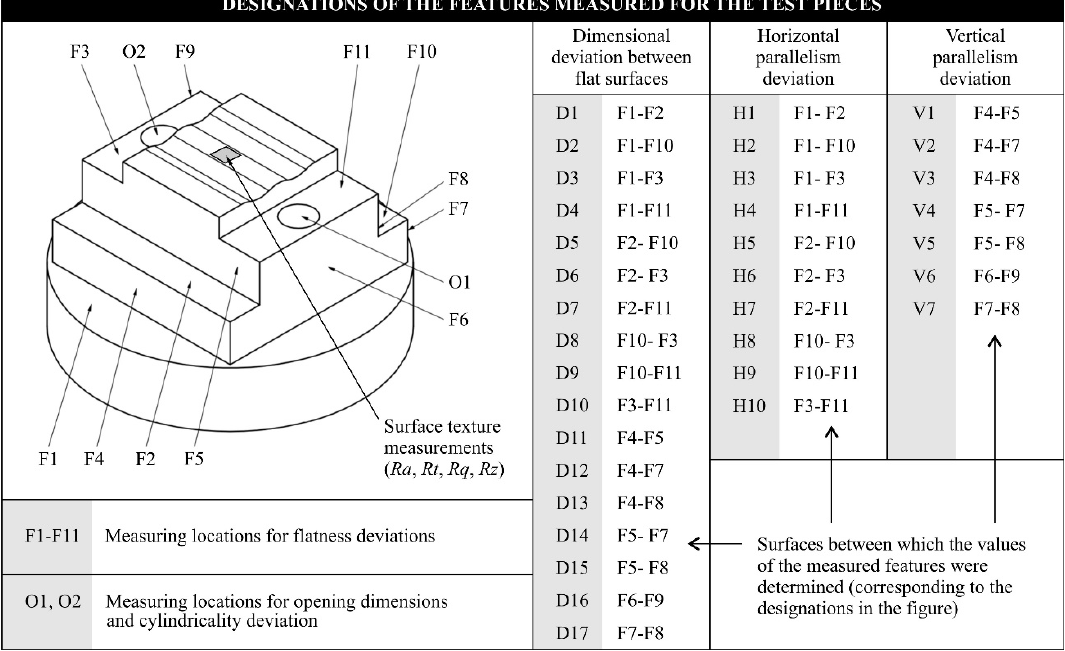
Figure 5. Assumed designations of the features measured for the test pieces.